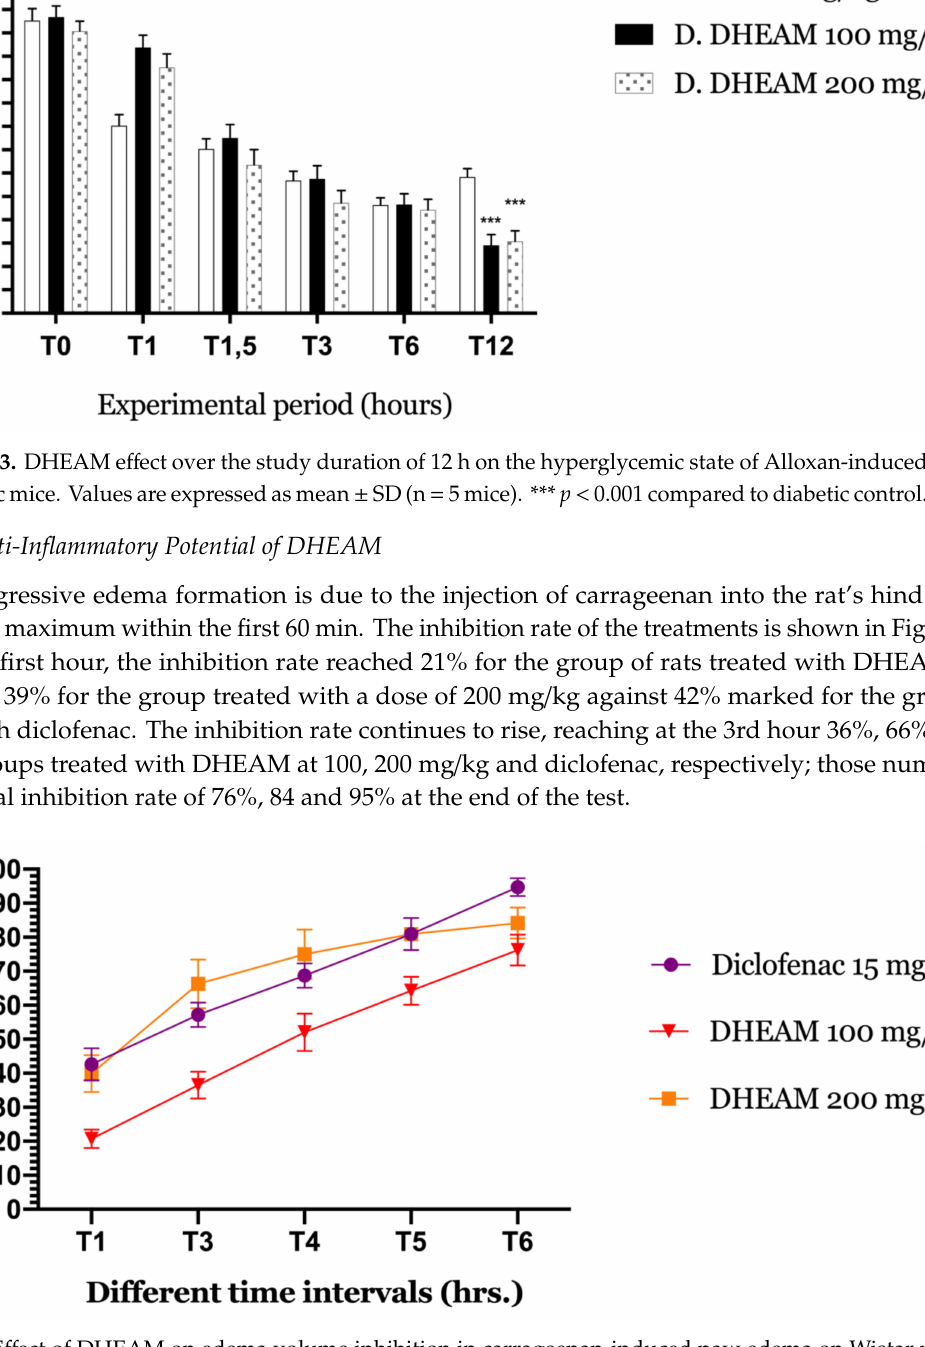
Figure 4. E ff ect of DHEAM on edema volume inhibition in carrageenan-induced paw edema on Wistar